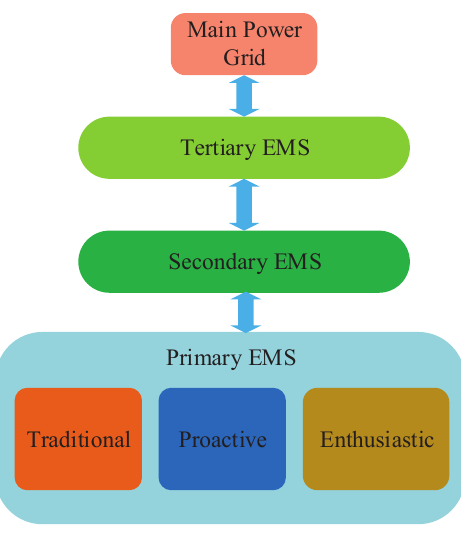
Figure 1. EMS configuration in a